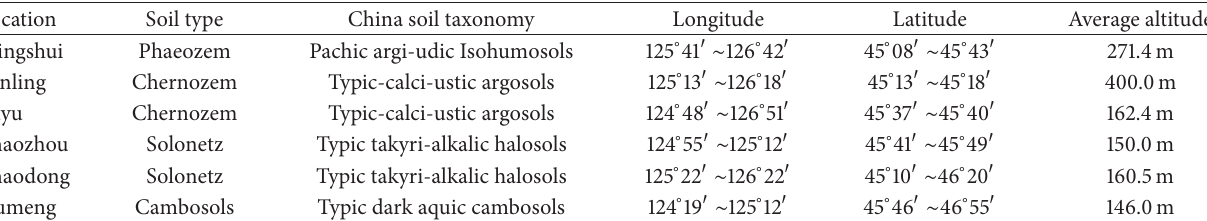
Table 1: Basic information of 6 sampling